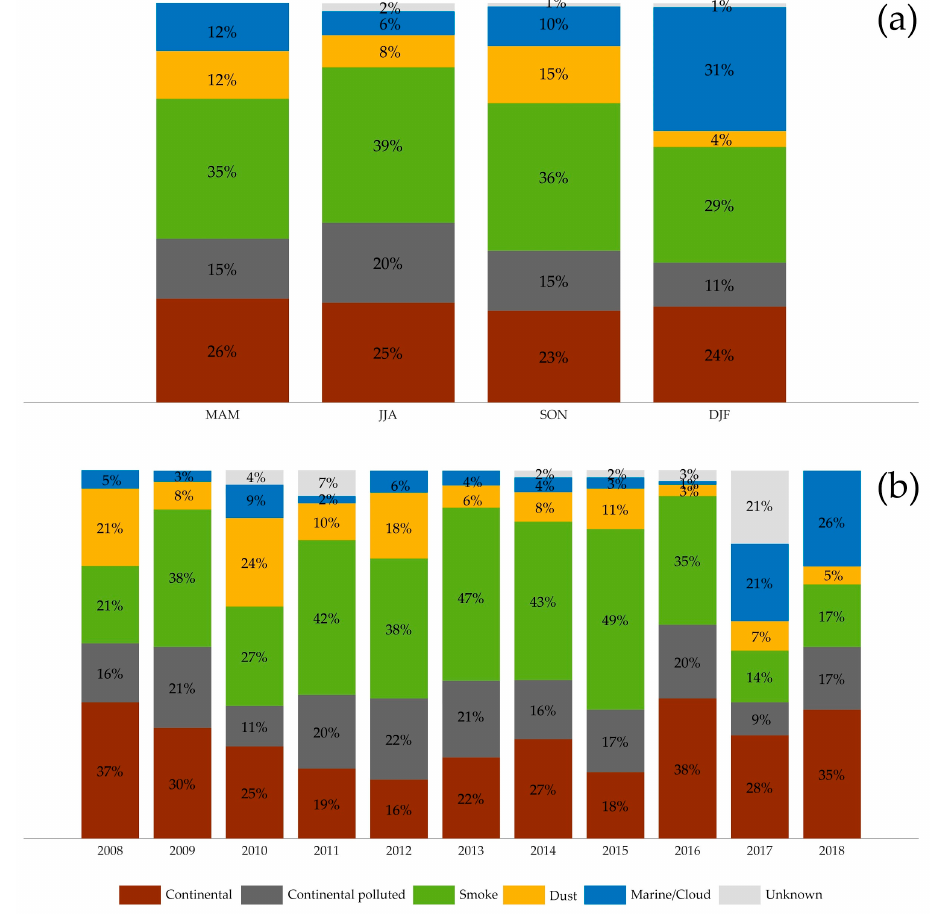
Figure 6. Time distribution of the prevalence of aerosol types retrieved with the NATALI code from EARLINET lidar measurements between 2008 and 2018: ( a ) seasonal distribution, ( b ) annual variations.